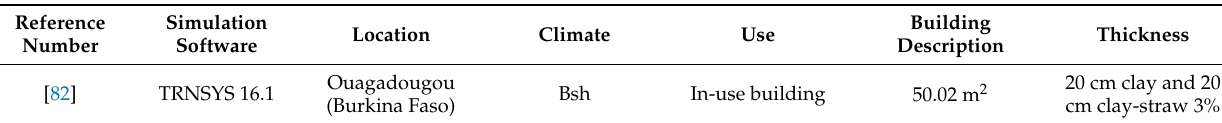
Table 15. Building characteristics and thermal performance of the straw clay simulated